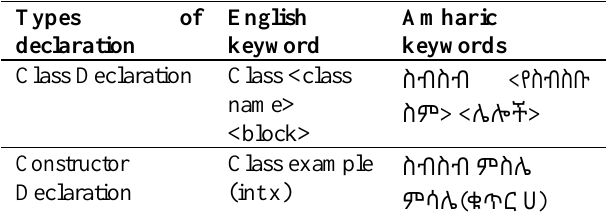
Table 2. Statement used in the